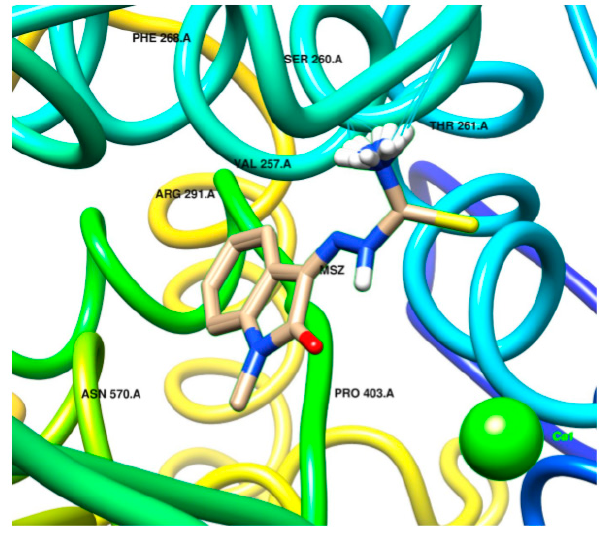
Figure 5. Visualization of docking of Ca–MSZ in 6M71_A. Molecular graphics and analyses per- formed with UCSF Chimera, developed by the Resource for Biocomputing, Visualization, and